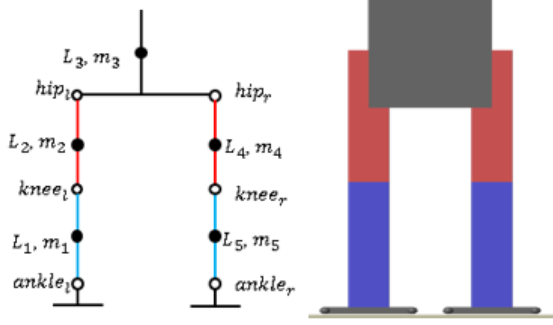
Figure 6. The link structure ( left ) and simulation model ( right ) of the biped